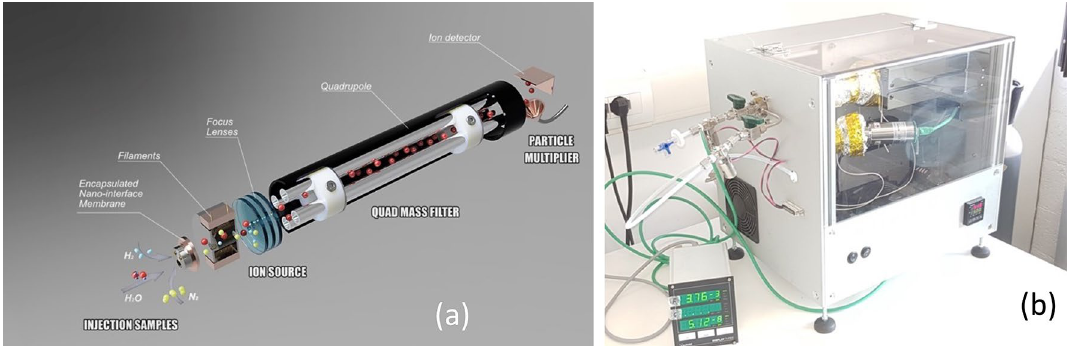
Figure 3. Mechanical conceptual structure of the nano interface integrated into an ion source ( a ) and prototype implementation ( b ). The image was generated by the Fusion 360 software (https:// www. autod esk. eu/ produ cts/ fusion- 360/ overv iew? term=1- YEAR& tab= subsc ripti on& plc=